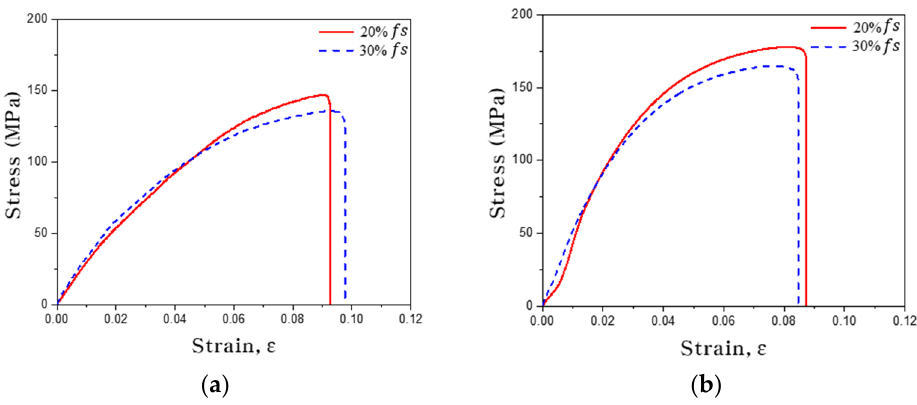
Figure 6. Stress–strain curve according to current input method: ( a ) DC, ( b ) AC.